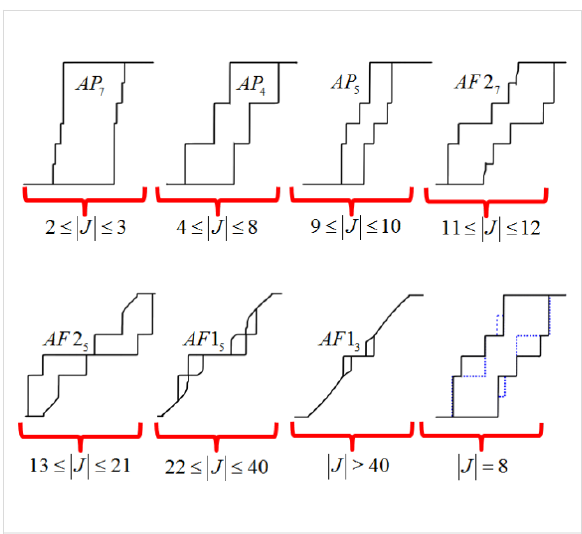
Figure 3: The hysteresis profiles for N = 6. There are fluctuating levels of magnetization plateaus as the energy balances of the system shift between metastable states. The magnetic field has to be cycled a number of times to obtain all of the possible Barkhausen jumps. For example, the last hysteresis loop shown will only display the black lines for many cycles. However, for this case of J = − 8, further cycles reveal the dashed (blue)